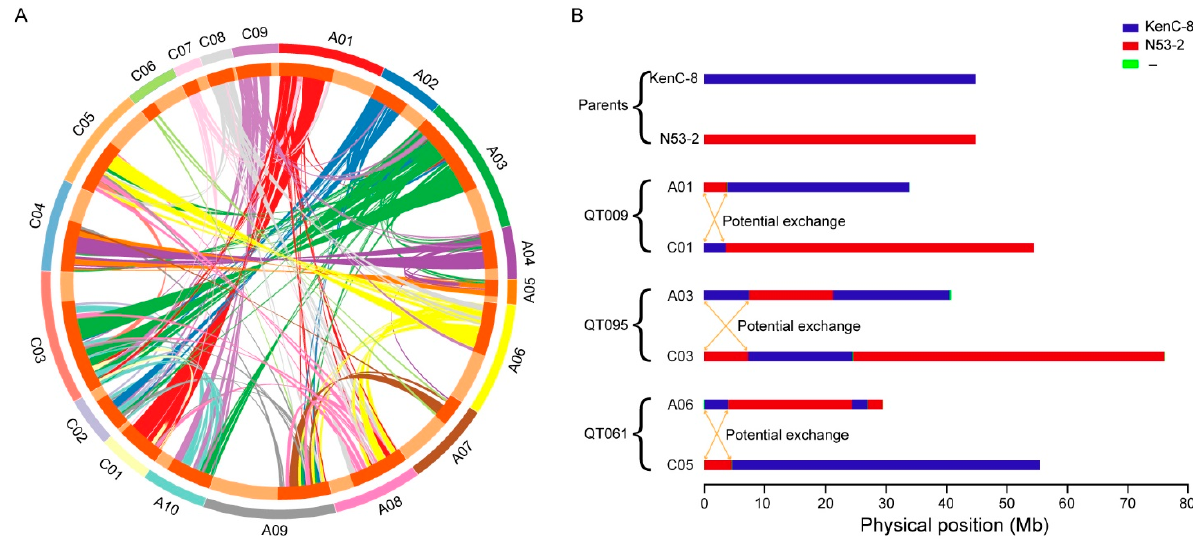
Figure 4. Potential exchanges between the chromosomes. ( A ) Homologous segment detection in the CO hot regions of the 19 chromosomes. Homologous segments were defined as those regions with more than 10 consecutive homologous genes, and the relationship between a pair of homologous and/or homologous genes is shown with a single line. The outer circle represents the chromosome name. In the inner circle, the orange-red bars represent the homologous genes, and the light tan bars represent the non-homologous regions. ( B ) Homologous genome exchanges may occur between the A and C subgenomes. Some lines, such as QT009, QT061, and QT095, may show homologous segment exchange in the CO hot regions.